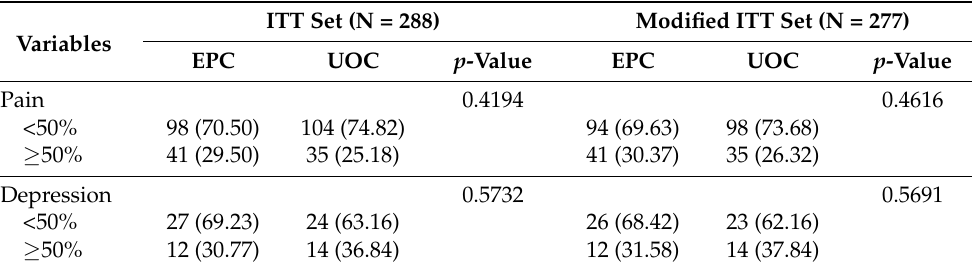
Table 2. Primary Outcome.